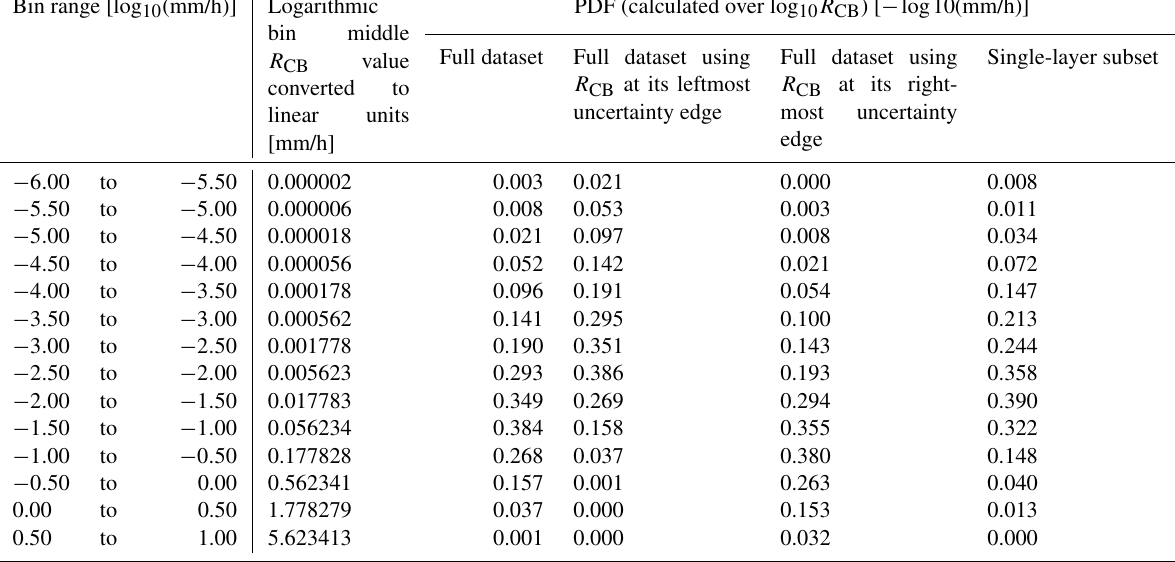
Table B1. PDF data illustrated in Fig.